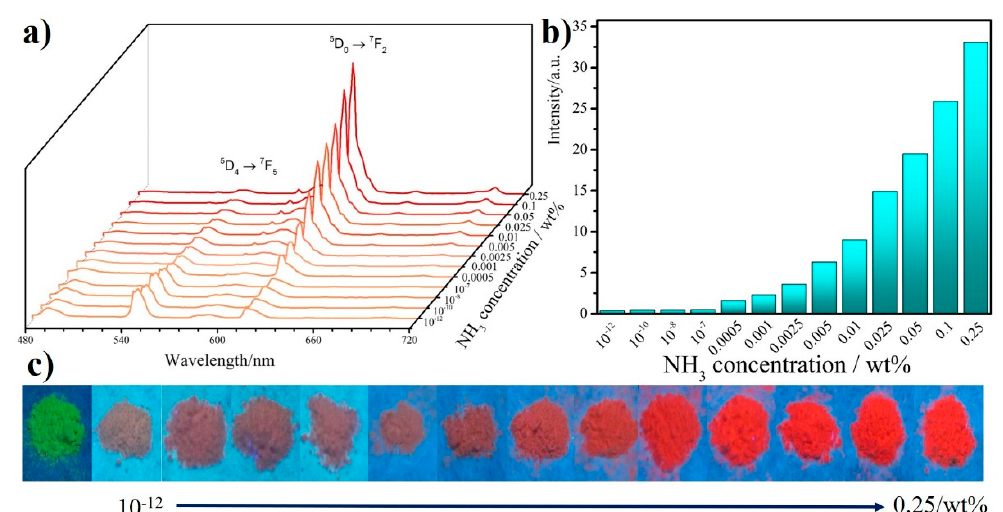
Figure 3. The emission spectra ( a , λ ex =365 nm) and emission intensity ratio of 5 D 0 → 7 F 2 transition of Eu 3+ to 5 D 4 → 7 F 5 transition of Tb 3+ (I Eu /I Tb , b ) of Eu 0.5 Tb 0.5 (HPBA n )@ZY after treatment with various concentration of aqueous ammonia, as well as the corresponding digital photograph of Eu 0.5 Tb 0.5 (HPBA n )@ZY ( c ).